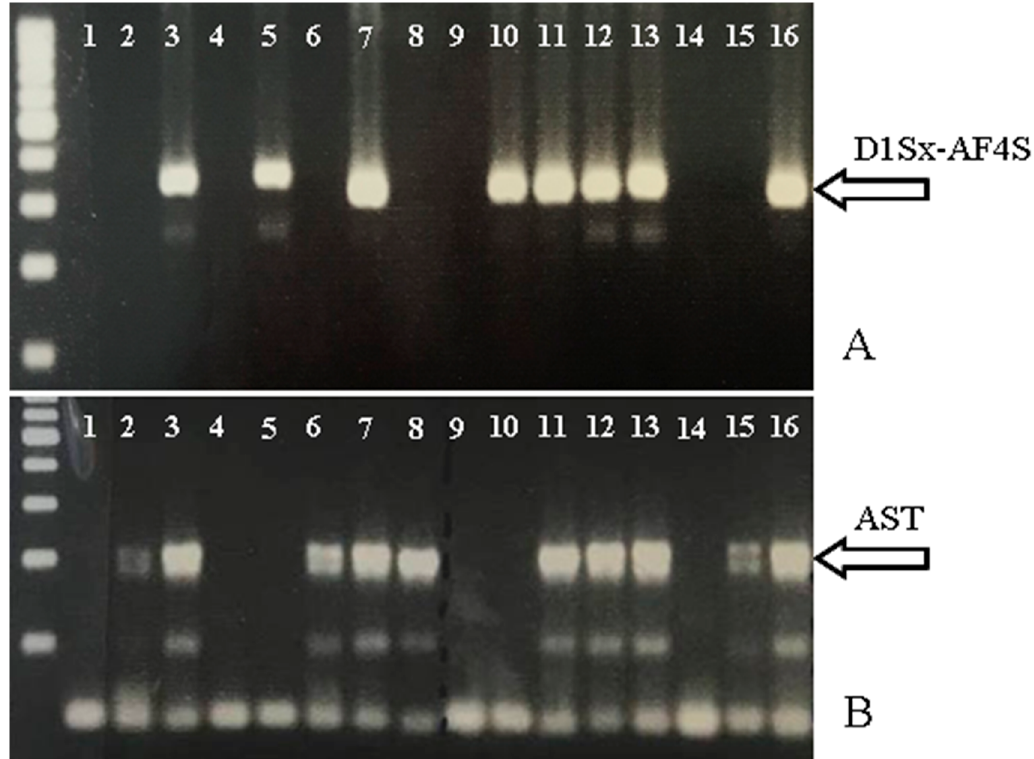
Figure 4. PCR results from agarose gel electrophoresis of 16 backcross (BC) individuals genotyped for AST and D1Sx-AF4S markers. ( A ) Presence of the marker (D1SX-AF4S) indicates ability for developing male flowers. ( B ) Absence of the marker means absence of any astringent allele (AST), which corresponds to a PCNA genotype The BC progenies are selected based on the absence of both markers, which corresponds to PCNA types without capability of the development of male flowers.